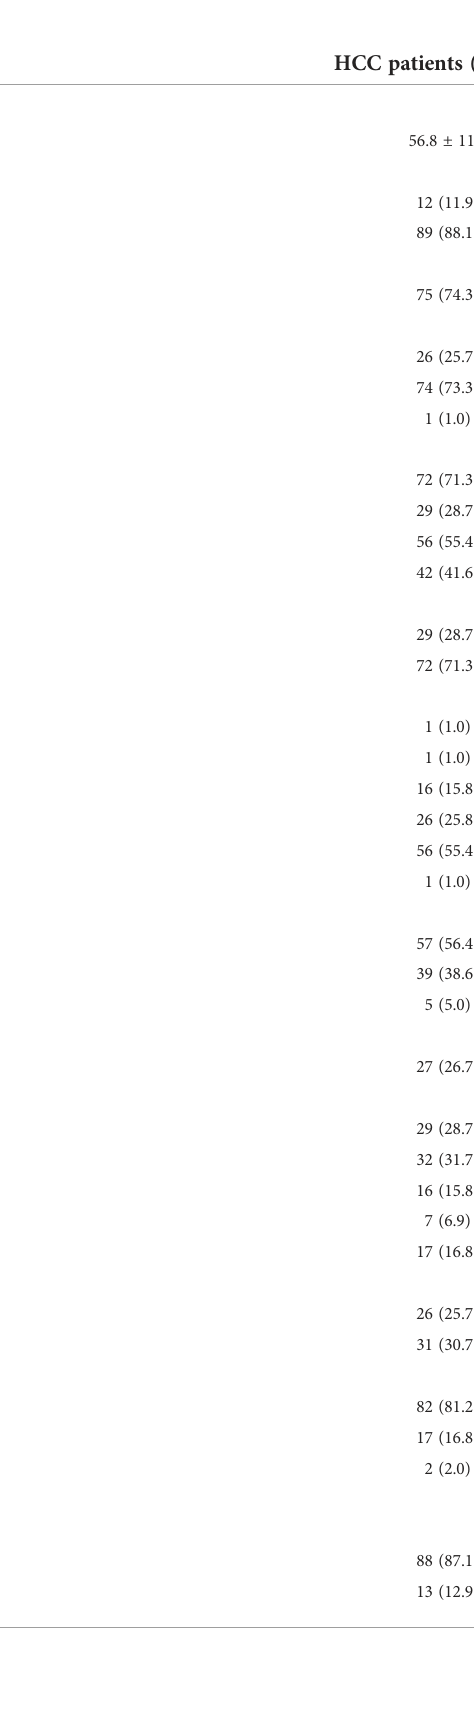
Table 1 Clinical